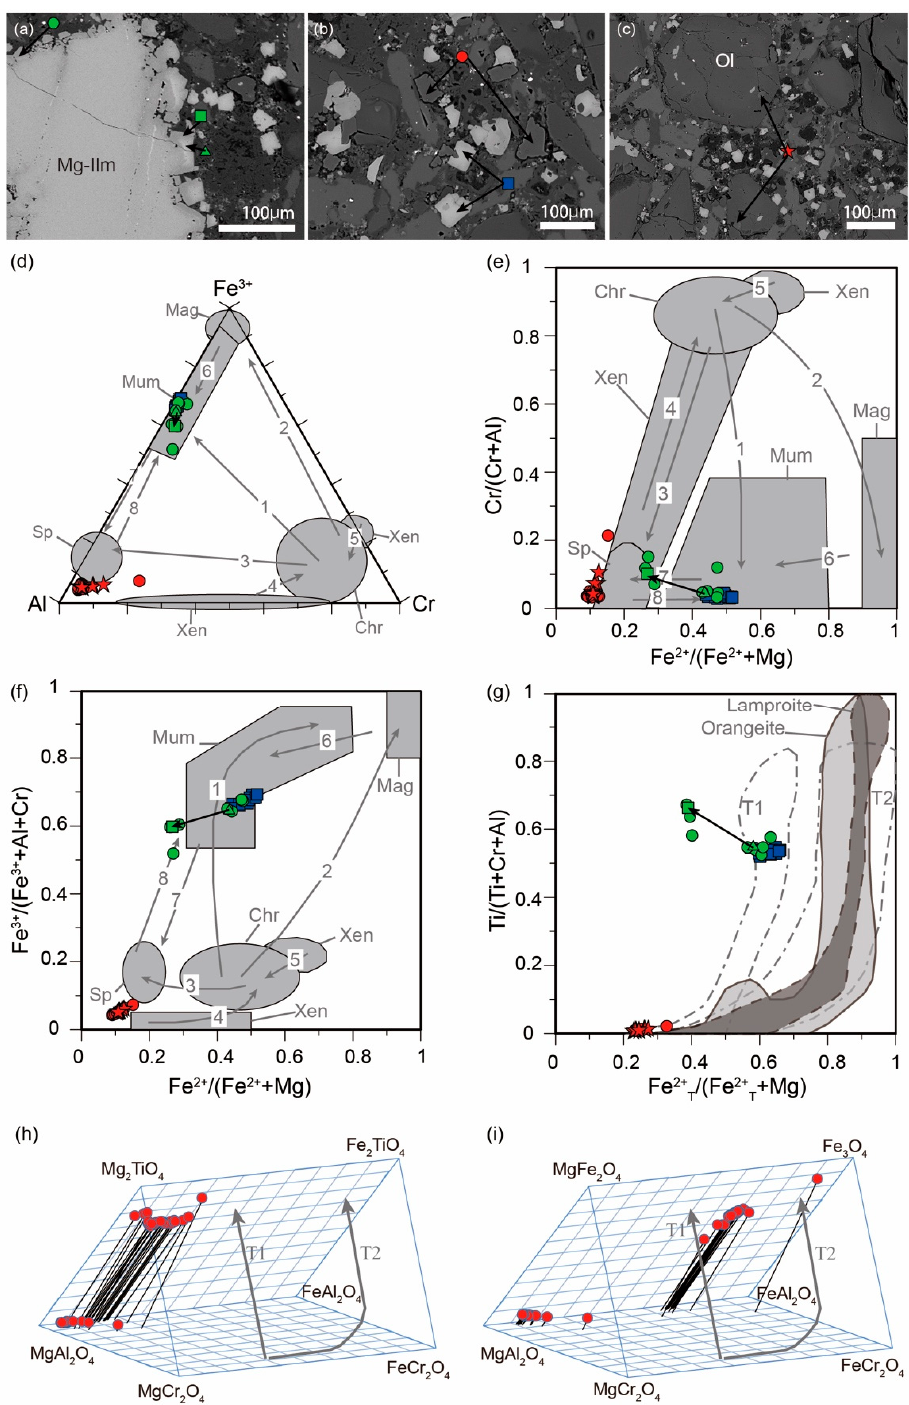
Figure 4. ( a – c ) Groundmass spinel with the situation of some analyzed points in Back-Scattered Electron (BSE) imaging. Compositions of primary spinels from Menominee in the following diagrams: ( d ) Al–Cr–Fe 3 + , ( e ) Fe 2 + / (Fe 2 + + Mg) vs. Cr / (Cr + Al), ( f ) Fe 2 + / (Fe 2 + + Mg) vs. Fe 3 + / (Fe 3 + + Cr + Al), and ( g ) Fe 2 + T / (Fe 2 + T + Mg) vs. Ti / (Ti + Cr + Al). Red symbols in ( d – g ) correspond to the points in ( a – c ) , and green circles are the rest of the primary spinels analyzed in this kimberlite; compositions of the spinels are also plotted in the reduced ( h ) and oxidized ( i ) spinel prisms. Compositional fields and trends from previous works are shaded in grey. ( d – f ) Sp: spinel s.s.; Xen: xenolith; and Chr: chromite, from [21]. ( g – i ) T1 and T2: trend 1 and trend 2, from [1,22].